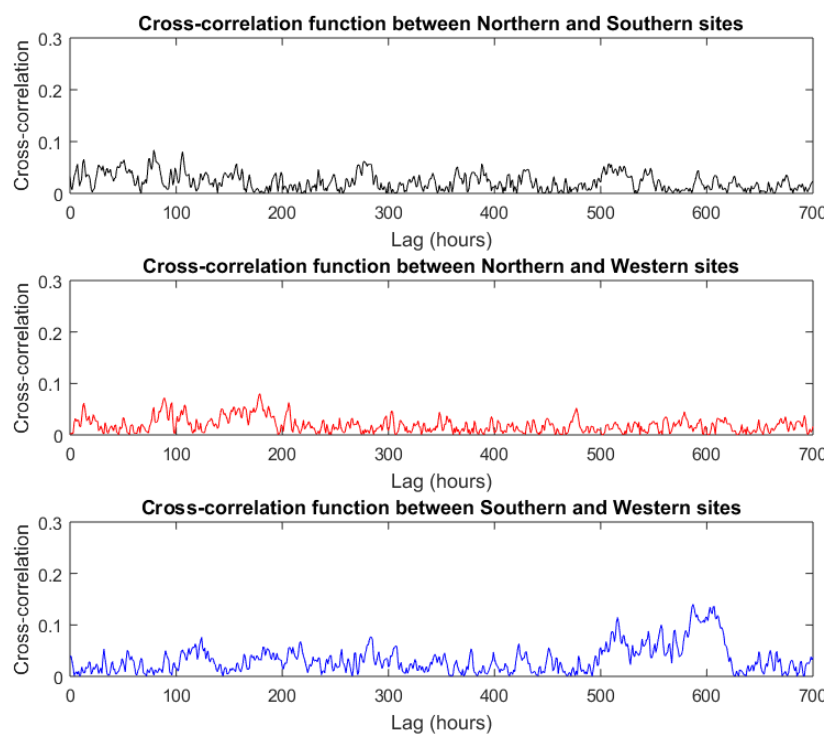
Figure 7. Cross-correlation function for 1 hour detected click numbers between Northern and Southern sites, Northern and Western sites, and Southern and Western sites.